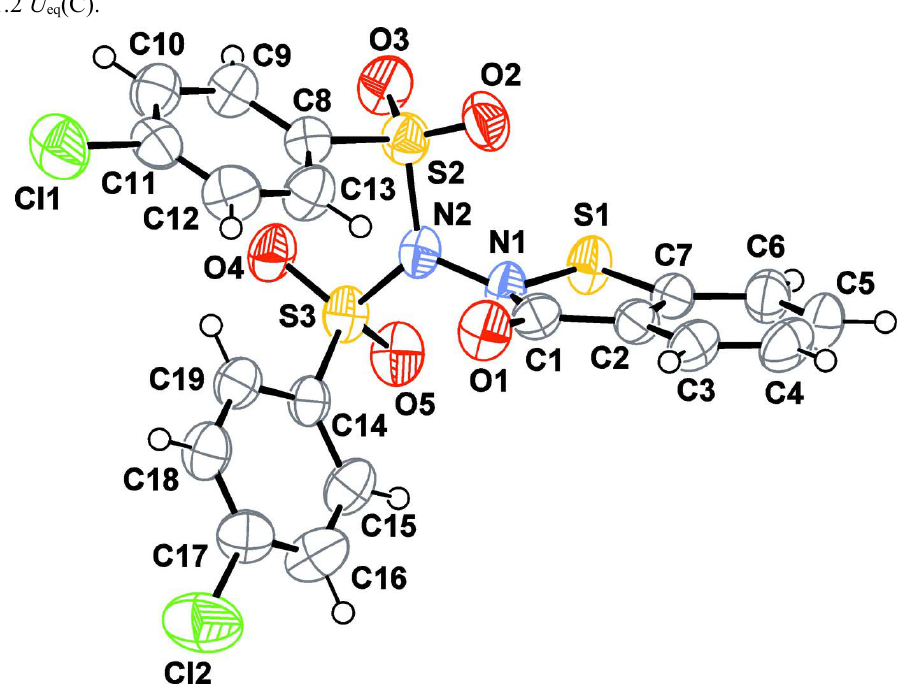
Figure 1 The molecular structure of the title compound, with displacement ellipsoids drawn at the 50% probability